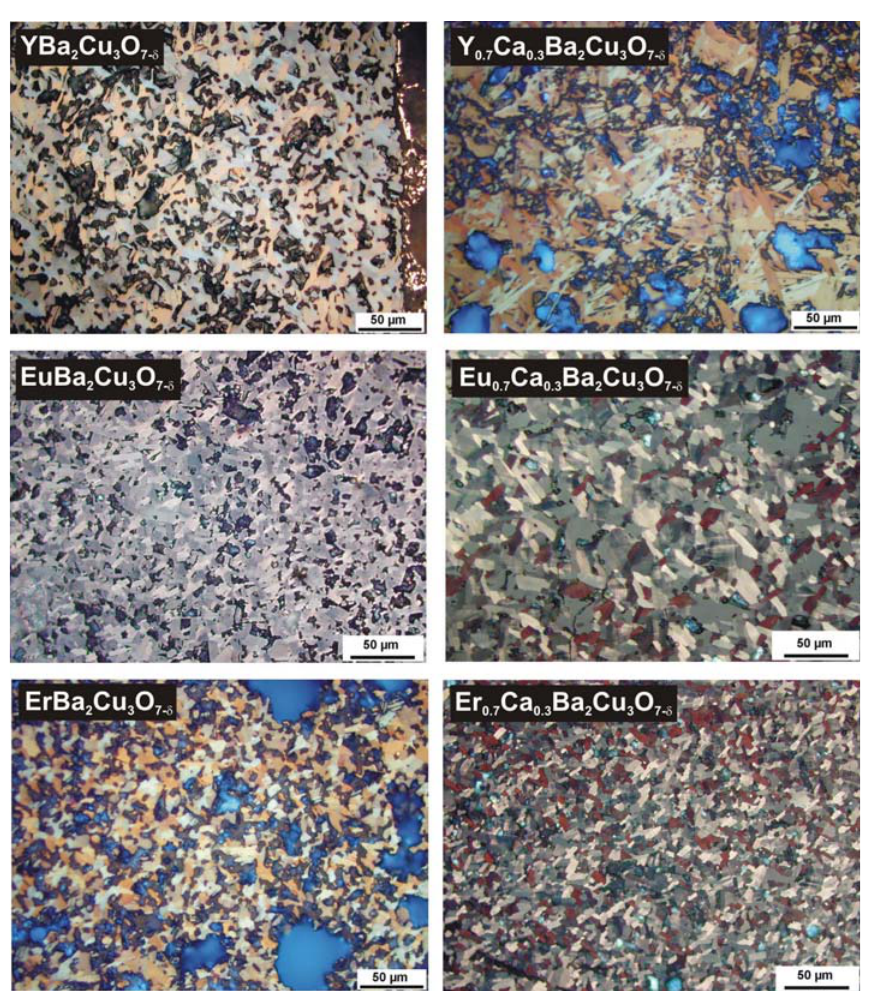
Fig. 4 Optical micrographs of RE